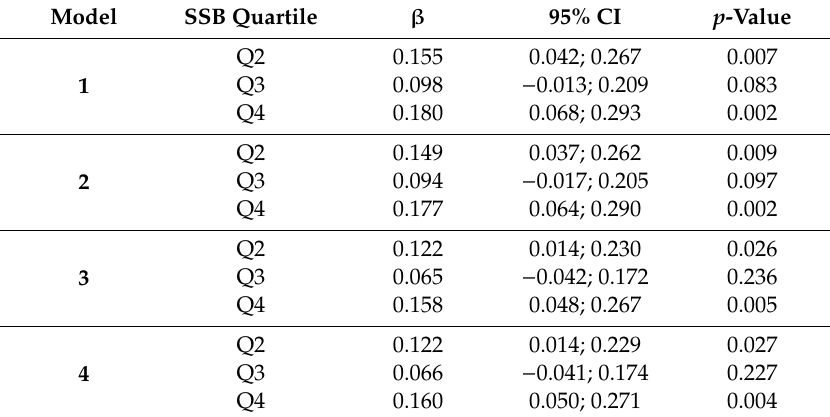
Table 2. Association of SSB consumption frequency quartile at age 5 / 6 years and change in BMI-z score over a 5-year